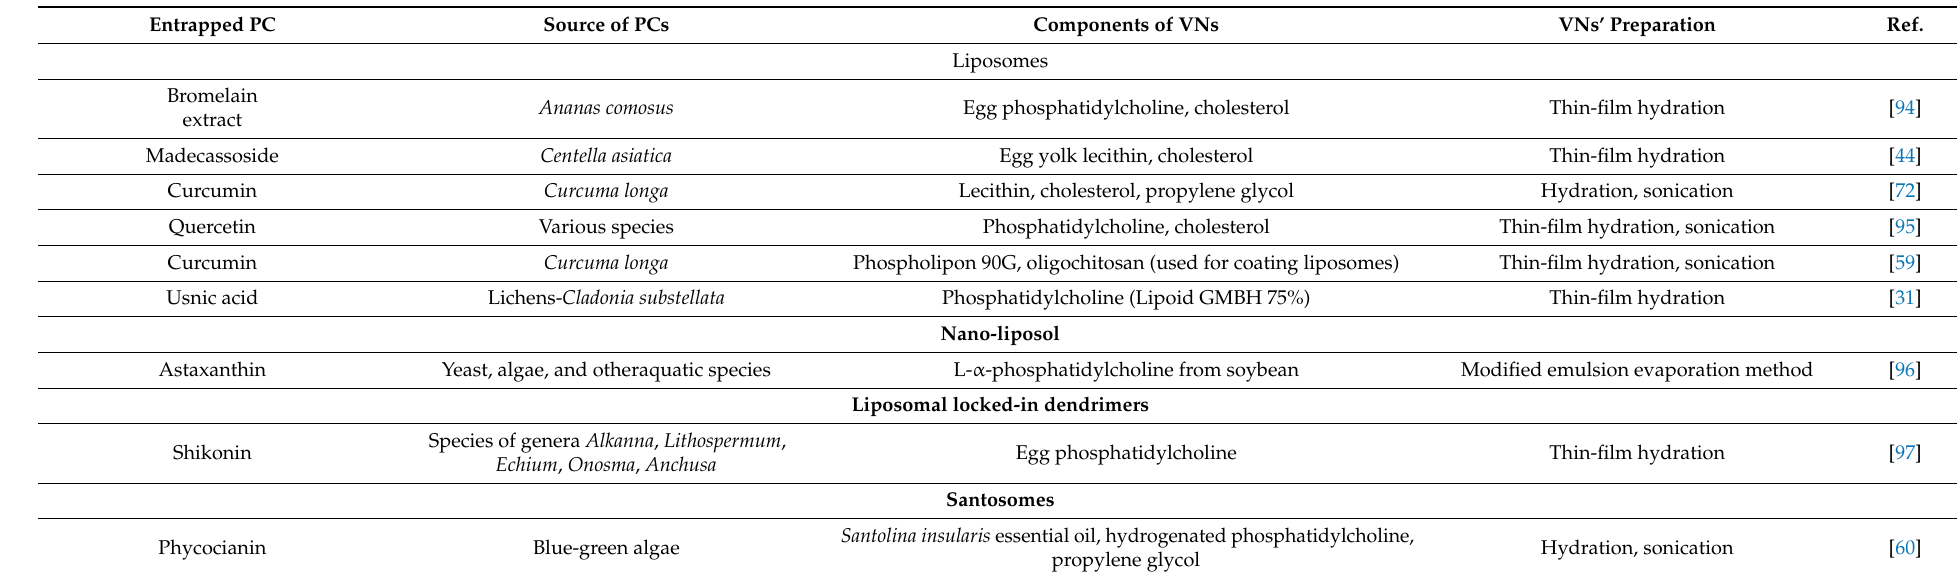
Table 2. Vesicular nanosystems as carriers for phytocompounds with wound-healing